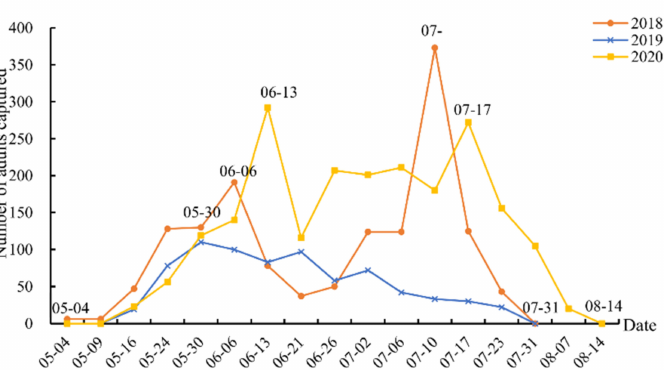
Figure 3. The number of M. saltuarius adults captured per week in three consecutive years. The numbers on the curves indicate the sampling date (month-day).